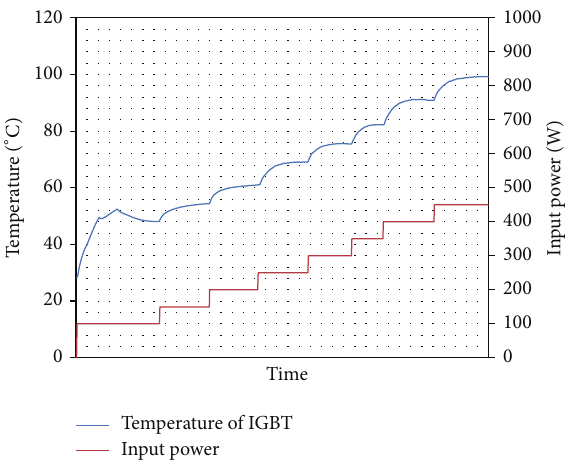
Figure 8: Dependence of temperature on input power of IGBT cooled by LHP with first variant of wick structure.